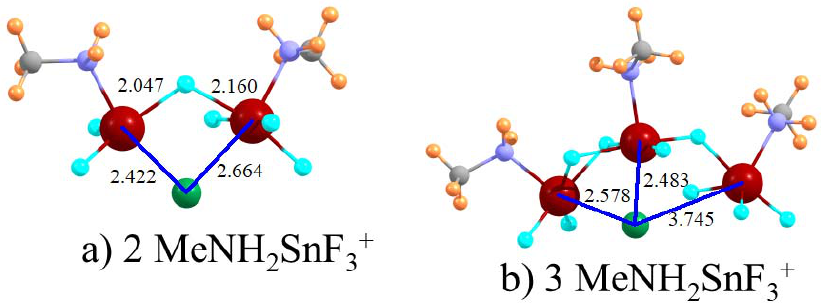
Figure 5. Geometries of Cl − with ( a ) 2 and ( b ) 3 CH 3 NH 2 SnF 3+ cations. Distances in Å.